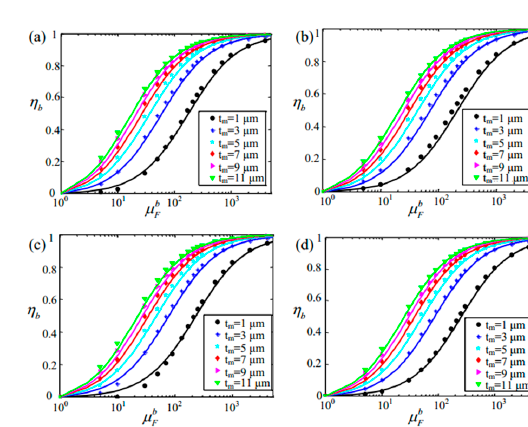
Figure 2. Modulation e ffi ciency acquired by calculating the finite element simulation model (FESM) and the equivalent magnetic circuit model (EMCM) for situations ( a – d ), respectively. The points are the results of the FESM, and the line diagrams are the fitted results using the EMCM. η b , modulation e ffi ciency, F.; t m, FMF thickness.